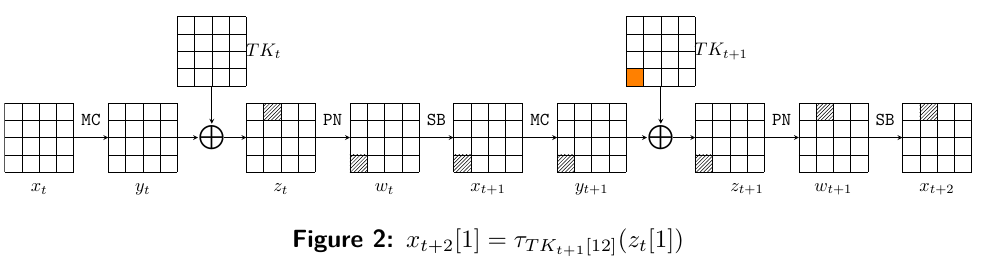
Figure 2: x t +2 [1] = τ